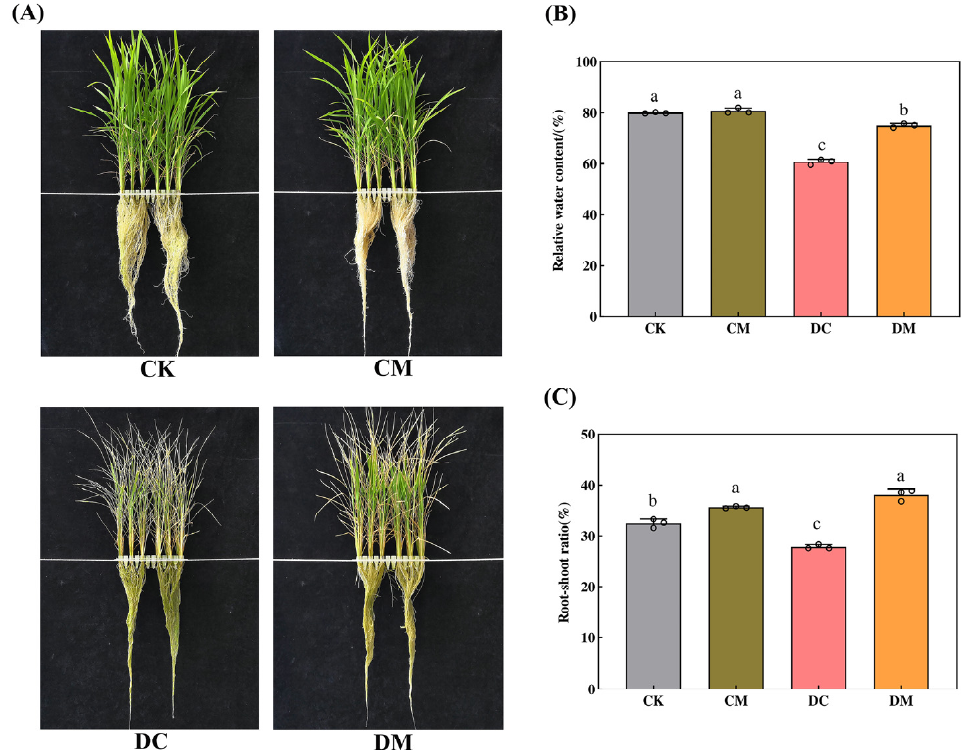
Figure 1. Effect of exogenous melatonin on rice seedling performance under drought stress. ( A ) Growth performance of rice seedlings under different treatments; ( B ) Relative water content; and ( C ) Root-shoot ratio. Data represent means ±SEs of three replicate samples. Different letters indi- cate significant differences ( n = 3 and p < 0.05). CK, control; CM, control pretreated with melatonin; DC, drought stress; and DM, drought-stressed plants pretreated with melatonin. The same applies to the figures below.